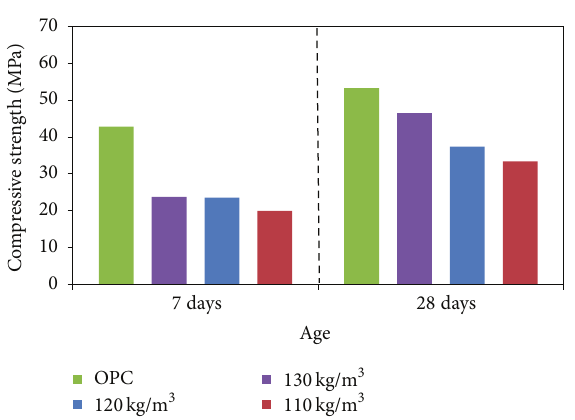
Figure 6: The compressive strength of high volume fly ash HFC in field.